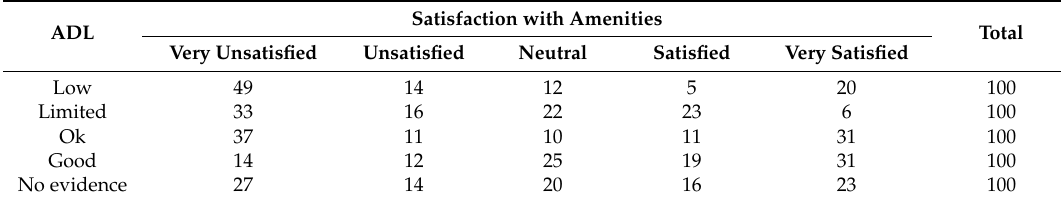
Table 10. Updated probabilities (in %) for satisfaction with amenities based on activities of daily living (ADL).